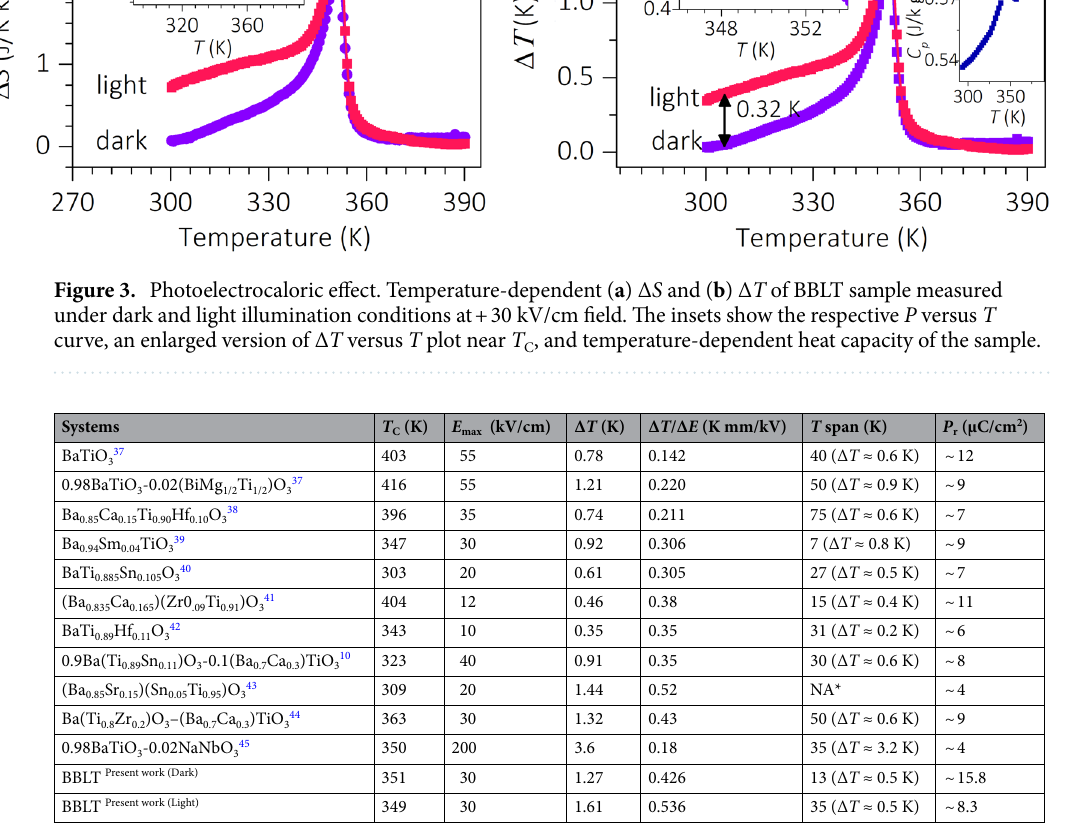
Table 1. The comparison of EC characteristics of BaTiO 3 -based ferroelectric systems obtained from the indirect measurements. Here mentioned P r values are measured at room temperature. * NA not available.